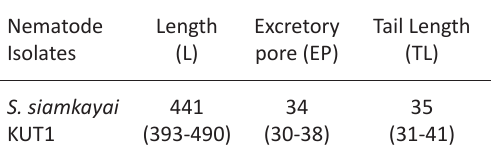
Table 1. Occurrence of Entomopathogenic Nematodes in different soil sample from Chempakathinal (H) Thadiyoor